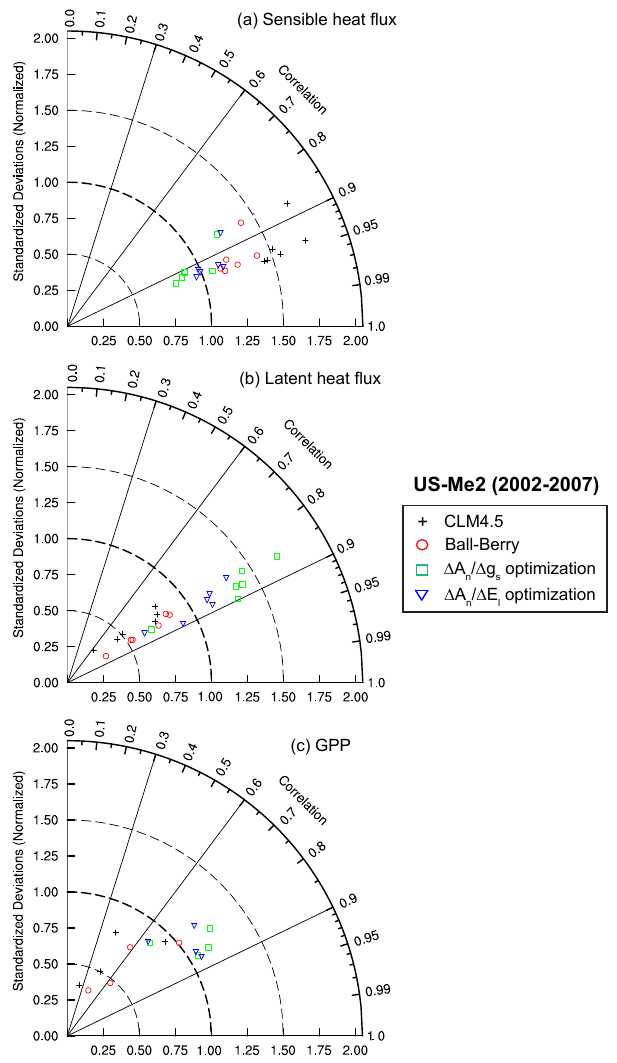
Figure 10. As in Fig. 8, but for US-Me2 (2002–2007).